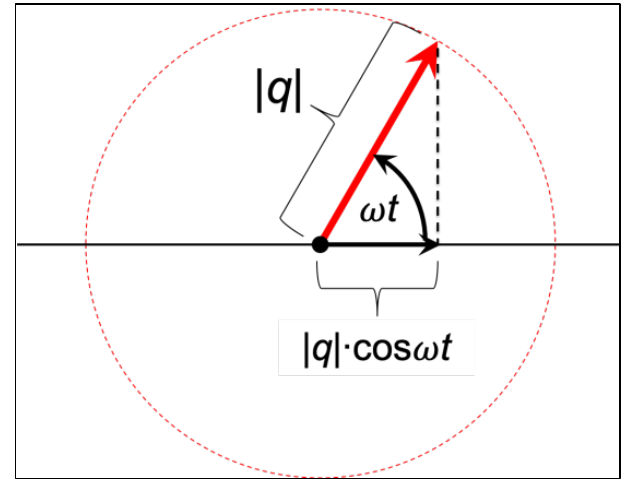
Figure A1. Phasor representation of an oscillation q · cos ω t .